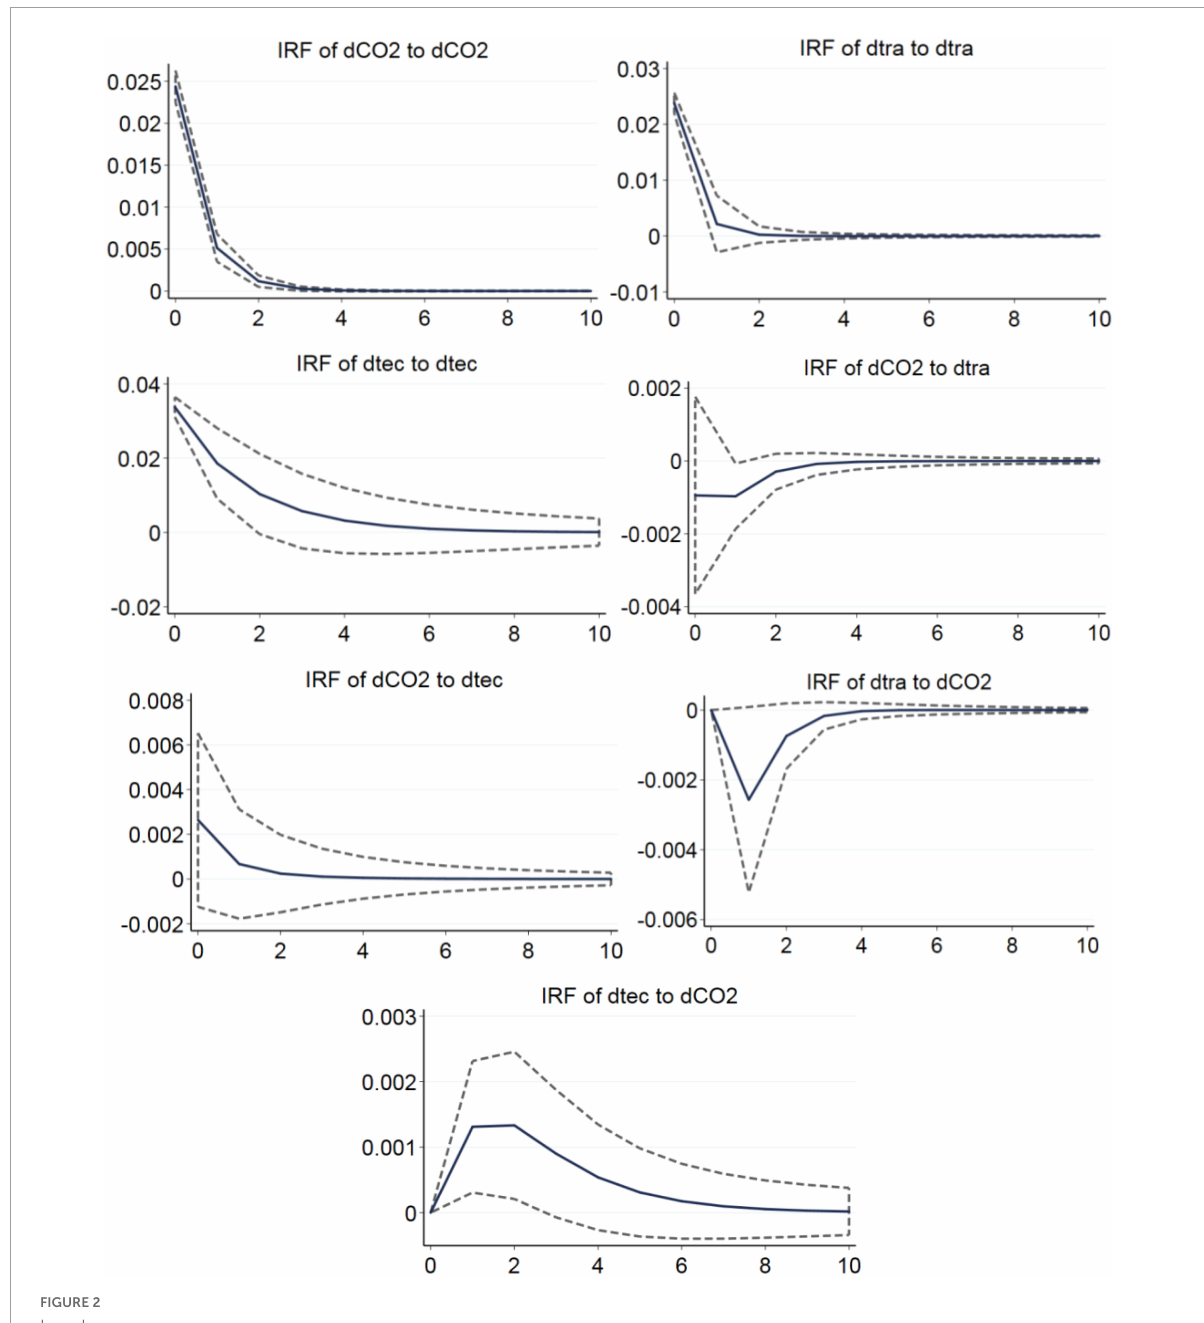
FIGURE2 Impulse response.